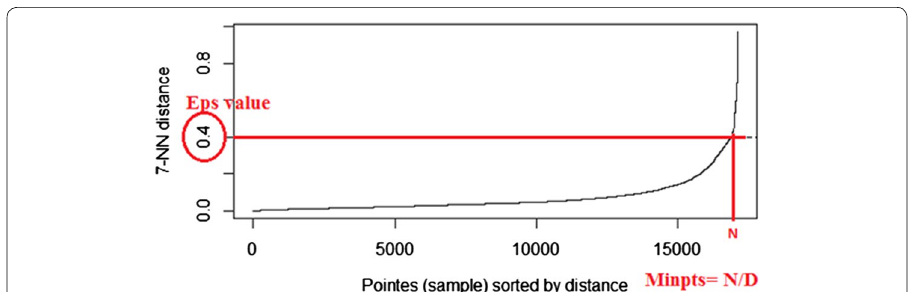
Fig. 5 KNN plot for given dataset